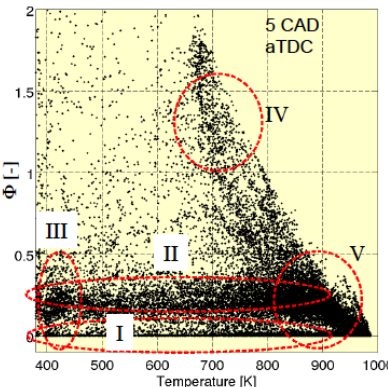
Figure 3. Fuel and air charge stratification in the baseline case 1. Five regions are identified as ( I ) an air charge without fuel, ( II ) a thermally stratified charge at constant equivalence ratio, in the wall vicinity, ( III ) a near wall mixture seen by the low temperature, and ( IV ) a fuel rich mixture in the central part of the engine from the last injection and ( V ) a premixed mixture between equivalence ratio 0.15 and 0.35 at around the ambient mean temperature.